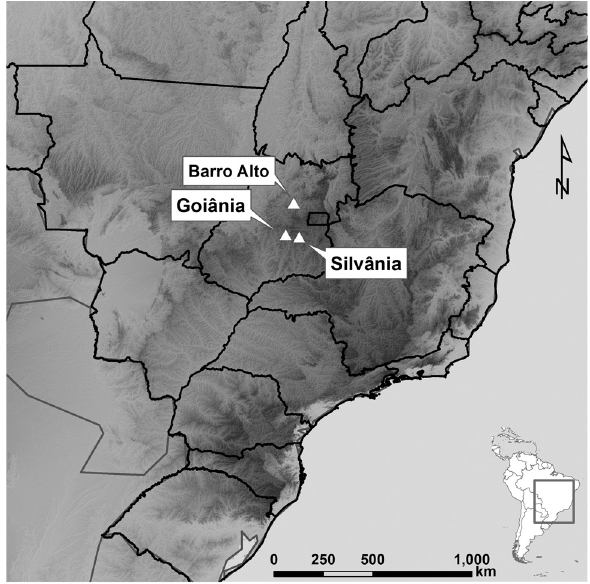
Figure 1 - Geografic view of Scinax constrictus and Ololygon centralis sampled sites. Scinax constrictus were collected at Barro Alto and Goiânia, GO. Ololygon centralis were found at its type-locality, Floresta Nacional de Silvânia, Silvânia,